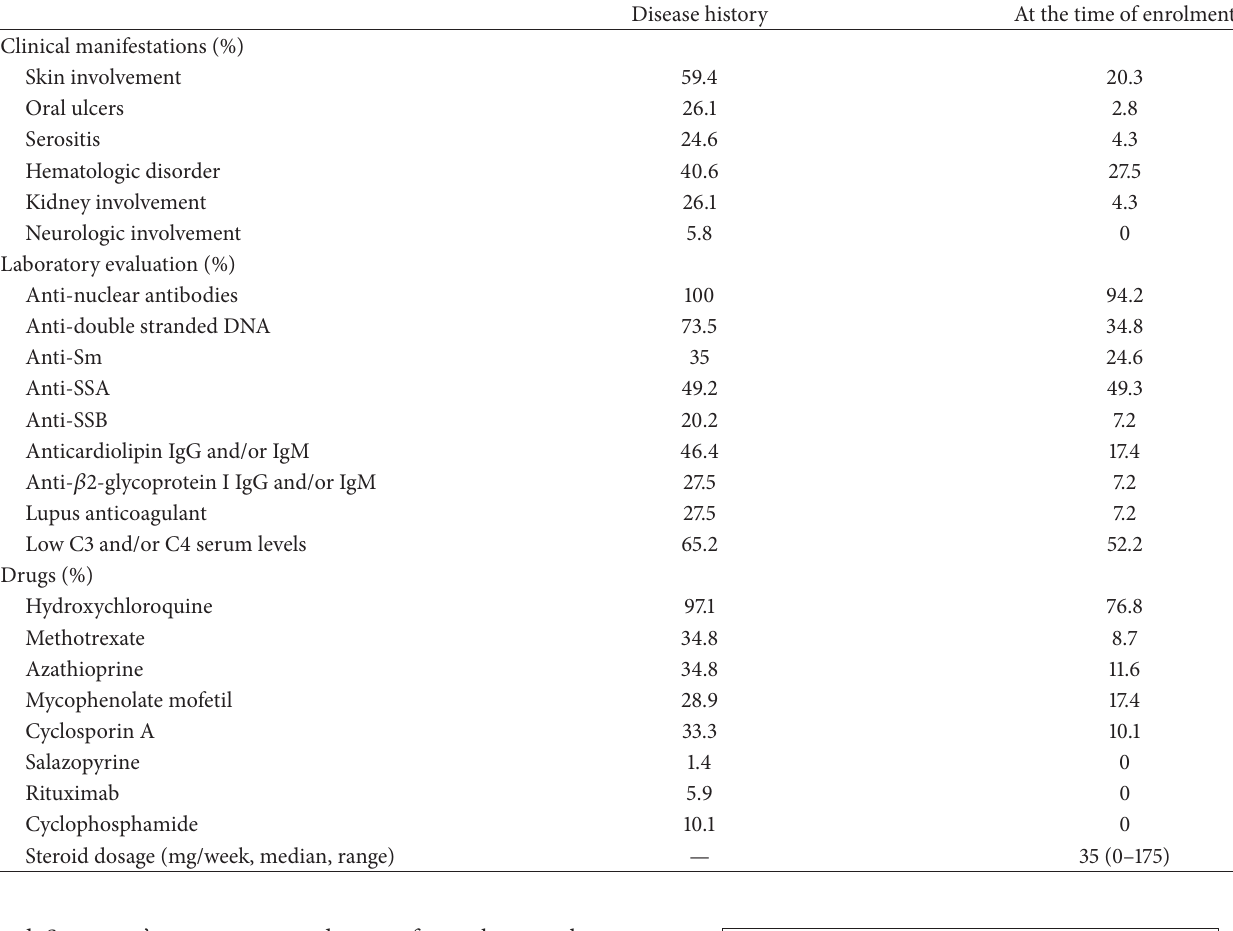
Table 1: Main demographic, clinical, laboratory, and therapeutic features of the SLE patients ( 𝑁 = 69 ) enrolled in the present study.